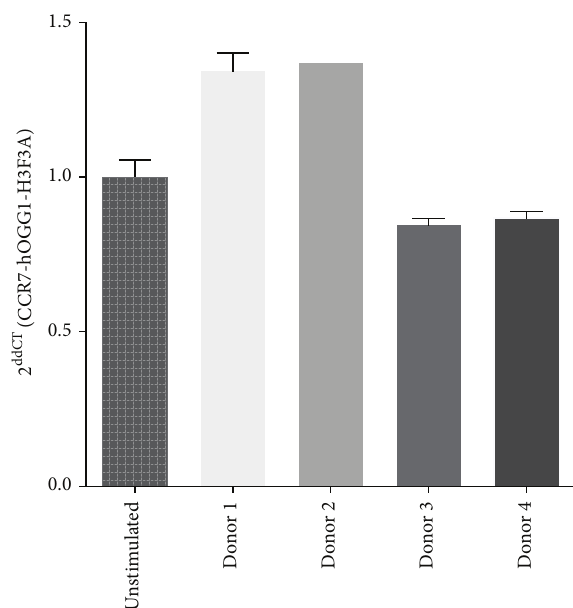
Figure 5: PGE 2 does not modulate CCR7 mRNA transcription in MDMs. MDMs were obtained from monocytes from four different healthy donors and were stimulated with 1 𝜇 M PGE 2 for 6 h. Total RNA was extracted and submitted to real-time PCR to detect the presence of CCR7 mRNA. Results shown are the means ( ± SD) of four